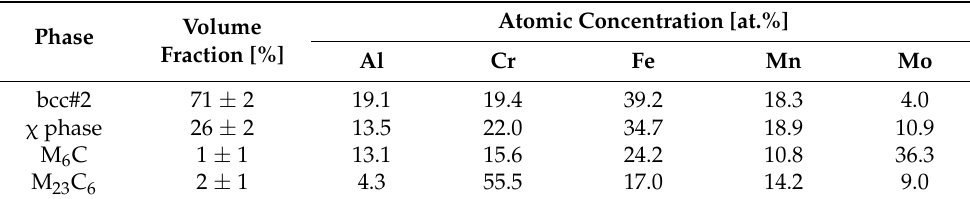
Figure 4. SEM-EDX mapping in the center of the bulk sample. Table 2. Chemical composition (without quantifying light elements, such as carbon or oxygen) and volume fraction of phases in the center of the bulk sample.